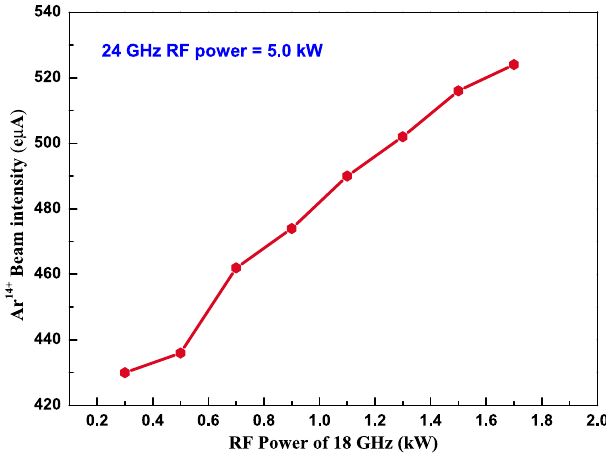
FIG. 20. 40 Ar 14 þ beam intensity dependence on microwave power of the second supplemental heating frequency 18 GHz when the main frequency 24 GHz power is fixed.